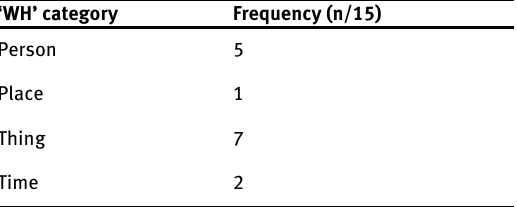
Table 4. Frequencies of restricted repair initiators (‘WH’ question words) in LSA ‘WH’